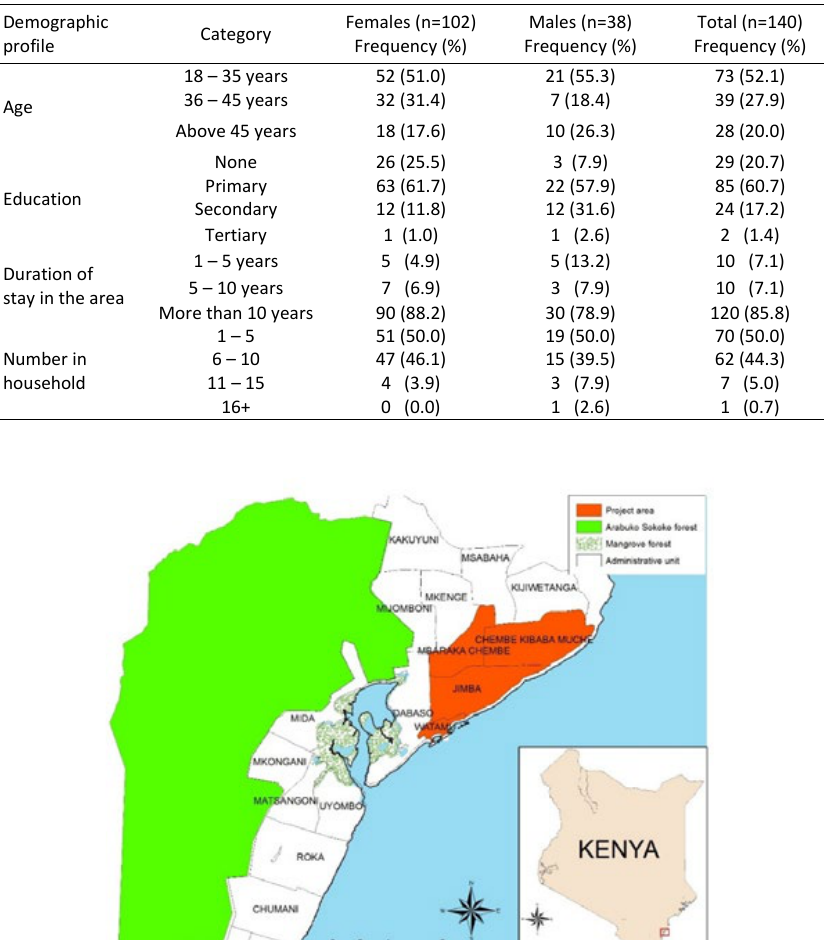
Table 2: Demographic Characteristics of Watamu residents